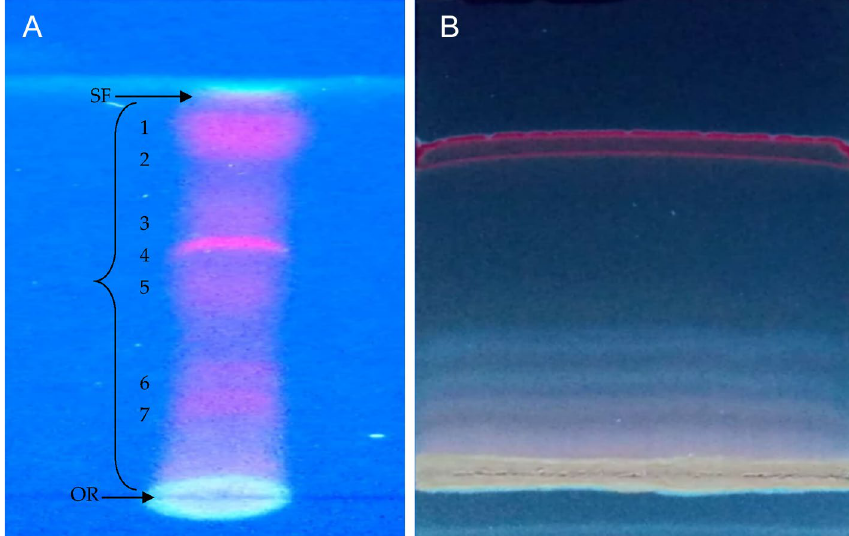
Figure 9. Thin layer chromatography of different C. sinuosa methylene chloride eluents ( A ) and preparative thin layer chromatography of the most effective eluent ( B ), the distance migrated by the solvent between the origin (OR) and solvent front (SF) is indicated near the brackets between those two boundaries.